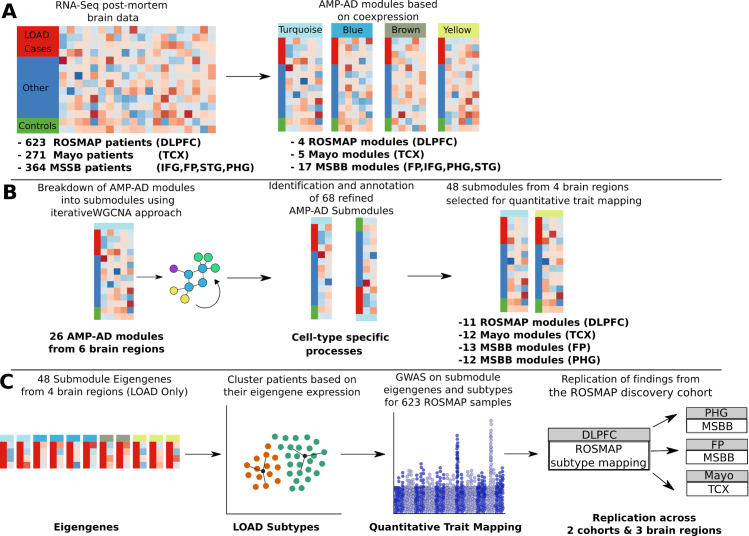
Method used in this study to map genetic drivers of LOAD pathology in the ROSMAP cohort.(A) RNA-Seq was performed on post-mortem brain samples from patients with Late-Onset Alzheimer’s Disease (LOAD). A modified procedure using seven different WGCNA protocols, followed by merging by clustering methods, was performed to obtain four modules based on gene co-expression. (B) Each of the 26 modules was subjected to iterativeWGCNA, a procedure that repeatedly performs WGCNA on expression data to generate highly correlated gene sets and exclude weakly correlated genes. 68 submodules were generated from the 26 modules. (C) The eigengene, or first principal component, was calculated for a subset of 48 submodules from four brain regions (DLPFC, TCX, FP, PHG) and used as a quantitative trait for single-variant association mapping. Furthermore, the eigengene expression for LOAD cases was used to perform cluster analysis and generate subtypes of LOAD cases. The Euclidean distance of each patient from each subtype centroid was used as additional quantitative trait–the subtype specificity metric–in a single-variant association mapping. ROSMAP mapping was used as the baseline, with the Mayo and MSBB cohorts serving as replicates.